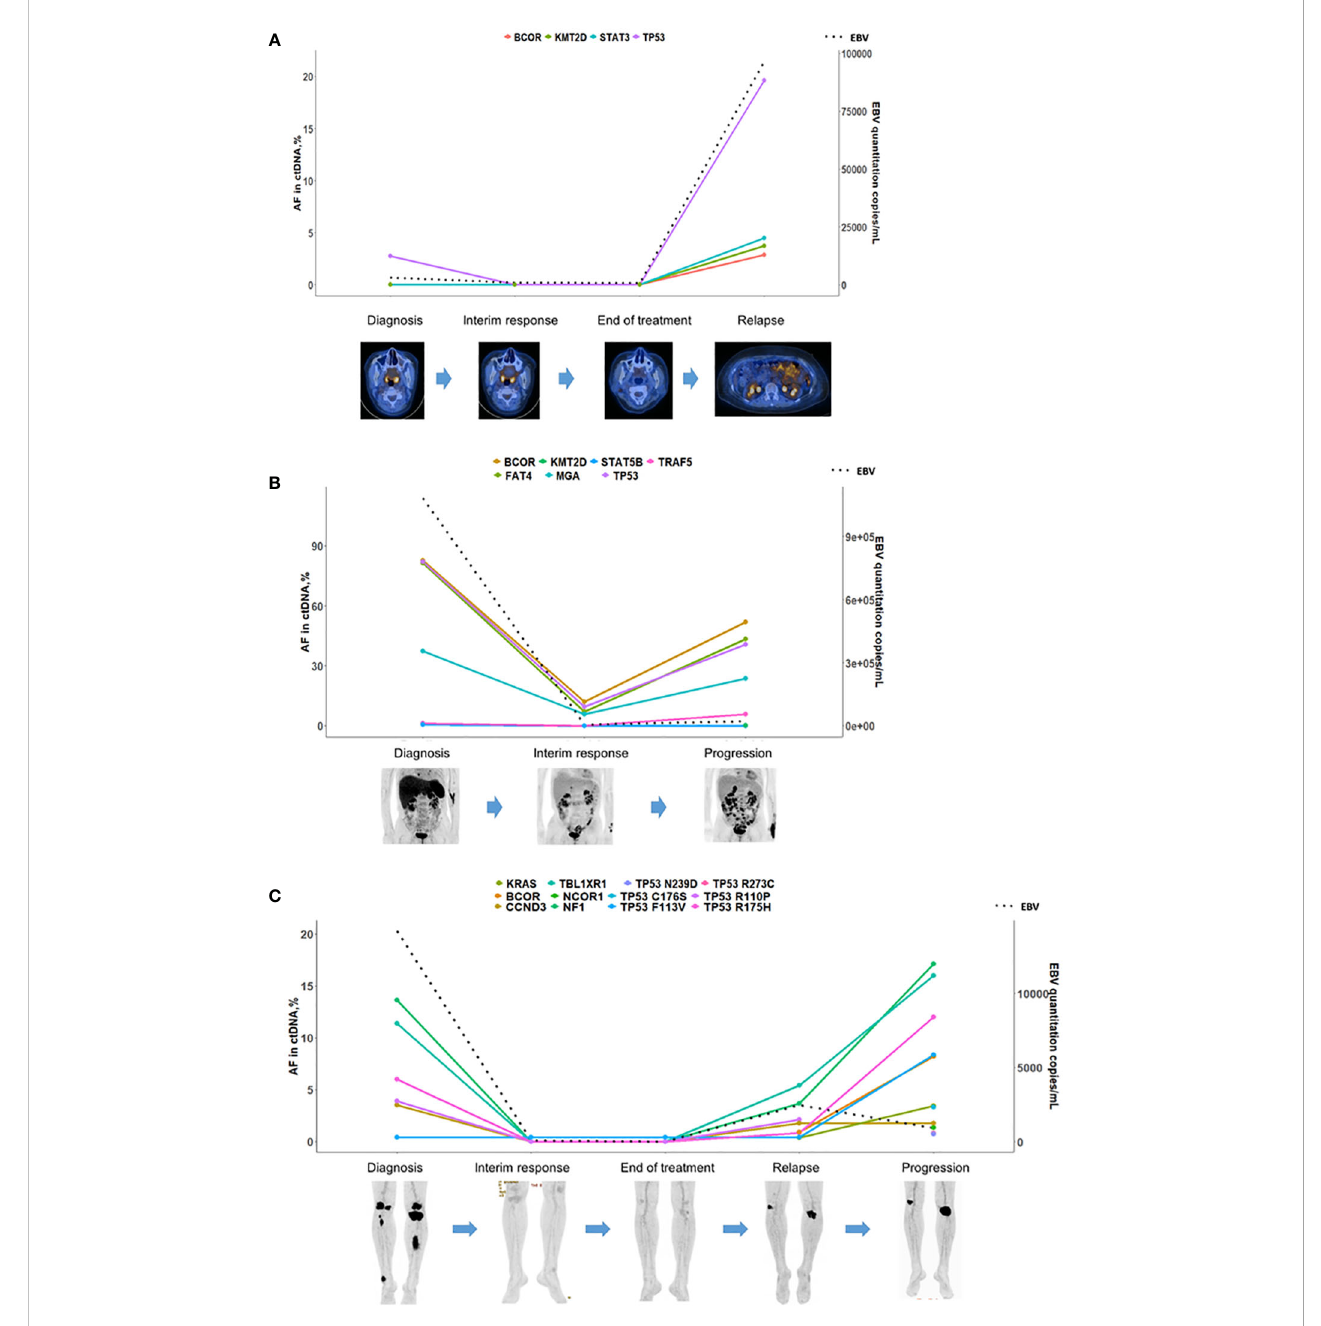
FIGURE 4 ctDNA mutation surveillance for disease progression/relapse in ENKTL patients. (A) A patient at stage 2 and in disease progression. The ctDNA mutation cleared before the complete remission assessed by PET/CT. The frequency of the TP53 mutation, which was detected in the baseline sample, increased with a dramatic spike along with the other three emerging mutations at disease progression. (B) A relapsed patient treated with Pembrolizumab. The mutation burden correlated with the clinical course of the patient and decreased in a sample at partial response and increased in a sample at disease progression. (C) A patient at stage 4 who achieved complete remission was monitored thereafter. Plasma ctDNA mutation was detected in a sample at the third visit, and molecular clonal expansion was observed samples at the fourth visit and disease progression. The dotted line in the fi gures indicated the quantitative results of